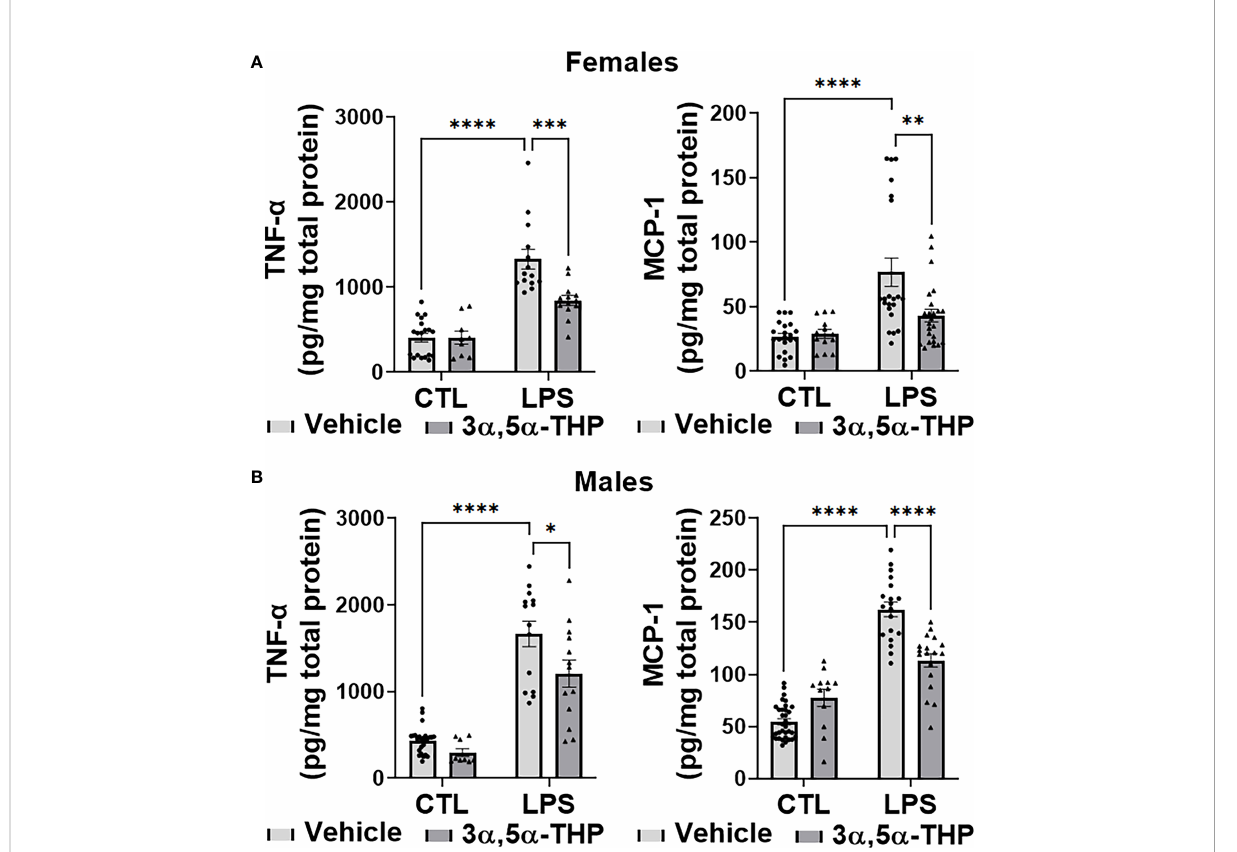
FIGURE 2 Allopregnanolone (3 a ,5 a -THP) inhibits LPS-induced increases of in fl ammatory cytokine TNF- a and chemokine MCP-1 in human monocyte- derived macrophages (hMDM) from both female and male donors. Each hMDM culture (n ≥ 12 cultures from 3-5 female (A) or 3-5 male (B) donors/grp) is shown as a single symbol. Cells were treated with the TLR4 agonist lipopolysaccharide (LPS) (1µg/ml; 24h) with or without allopregnanolone (1µM; 24h). LPS caused a signi fi cant increase in the levels of TNF- a (~70% in hMDM from both female and male donors) and MCP-1 (~65% in hMDM from both female and male donors) relative to vehicle control (CTL). The increases of TNF- a were partially inhibited by allopregnanolone (~55% and ~35% inhibition in hMDM from female (A) and male (B) donors, respectively) (Two-way ANOVA, Tukey ’ s post